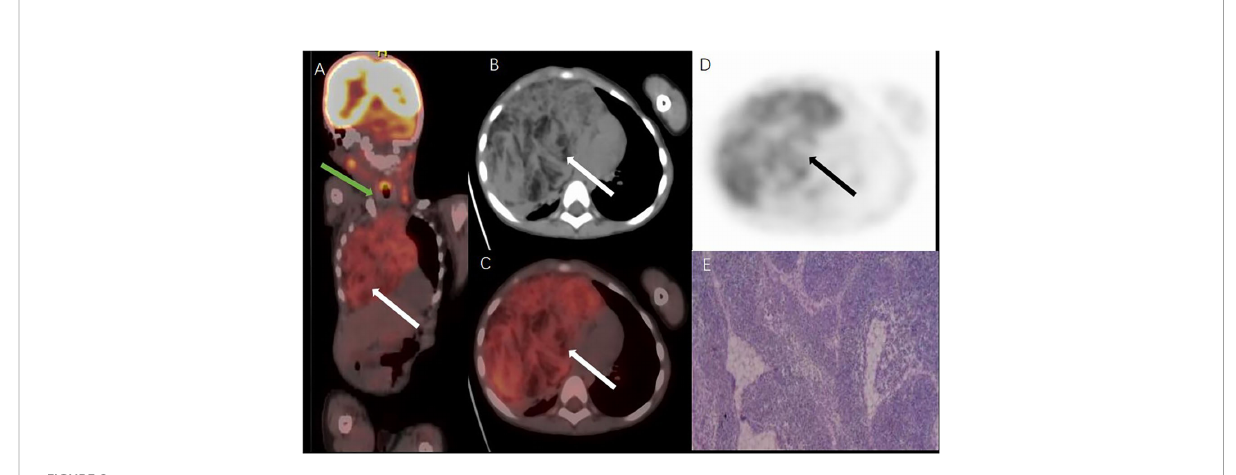
FIGURE 2 18F FDG PETCT images and pathologic